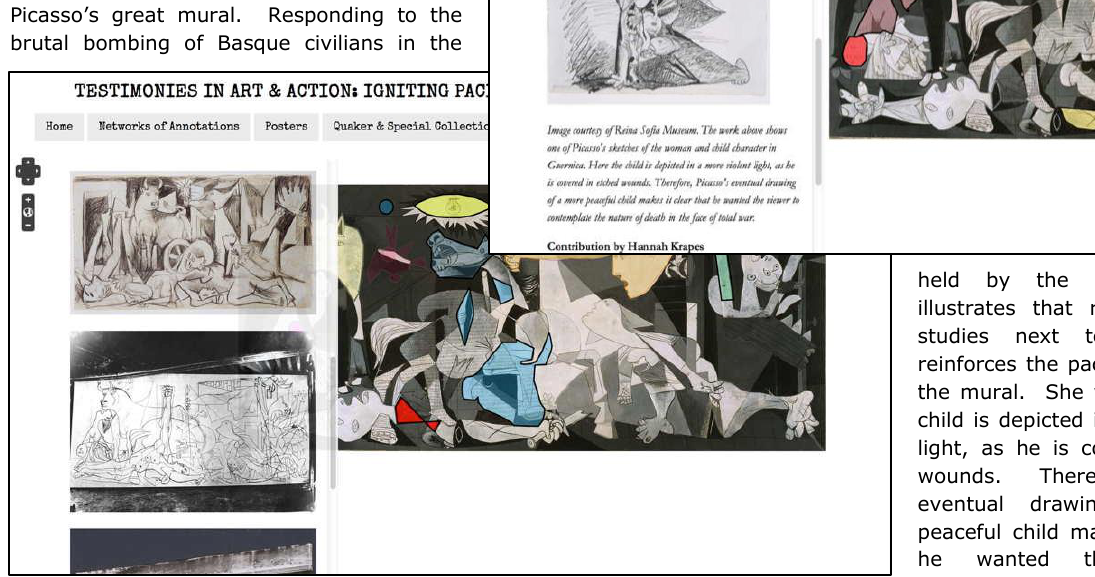
FIGURE 2: JOSHUA HILSCHER EXPLORES THE PRESENCE OF THE LIGHT BULB THROUGH THE STAGES OF GUERNICA.